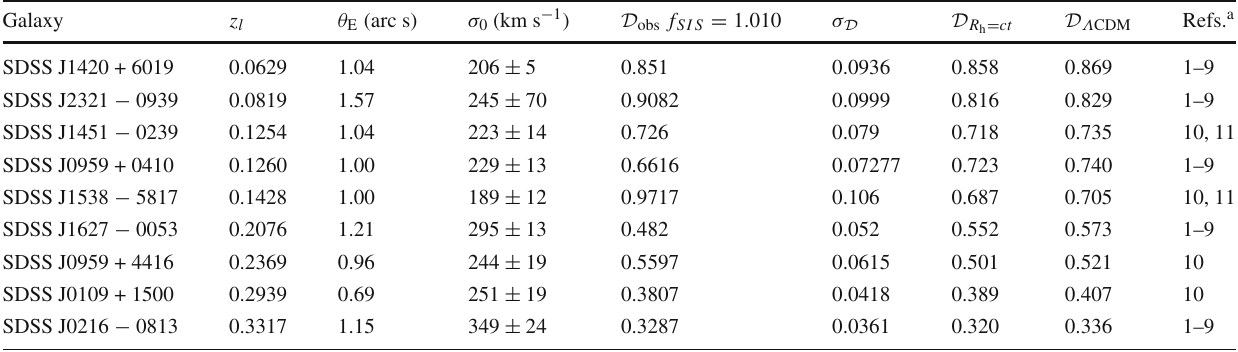
Table 5 Strong gravitational lensing systems with 0 . 52 < z s < 0 . 545